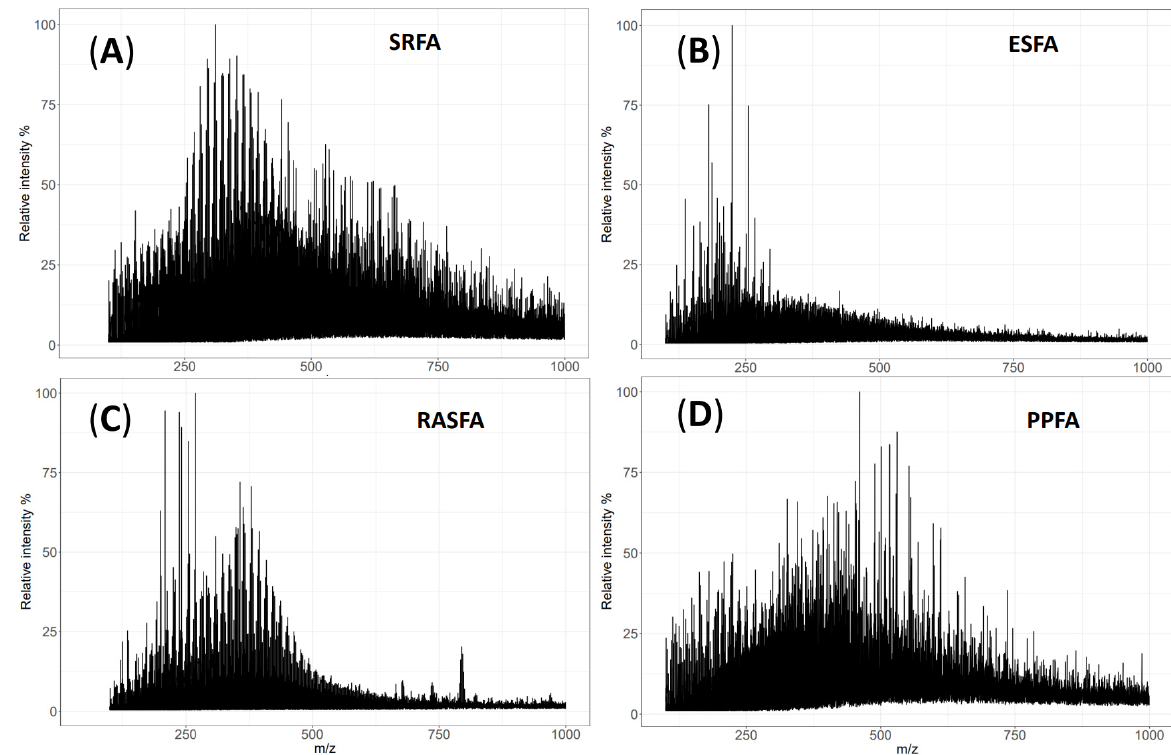
Figure 2. Negative ESI-QTOF-MS mass spectra of fulvic acids (FA) extracted from: ( A ) Suwannee River (SRFA), ( B ) Elliott soil (ESFA), ( C ) tank waters from RAS (RASFA) and ( D ) Pahokee Peat soil (PPFA). Table 1. Characteristics of the fulvic acid (FA) fraction of dissolved organic matter (DOM) based on the intensity weight-averaged (wa) values of the identified peaks by ESI-QTOF-MS under negative mode in the Suwannee River, Elliott soil, Pahokee Peat fulvic acid standards (SRFA, ESFA and PPFA) from IHSS together with the FA fraction of DOM from RAS (RASFA). Identified Samples H/C wa Formulas